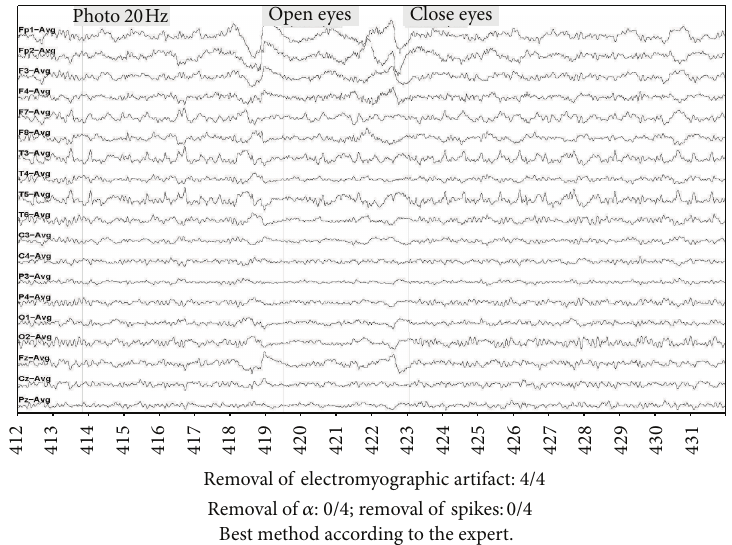
Figure 9: Filtering result with DAFOP method.